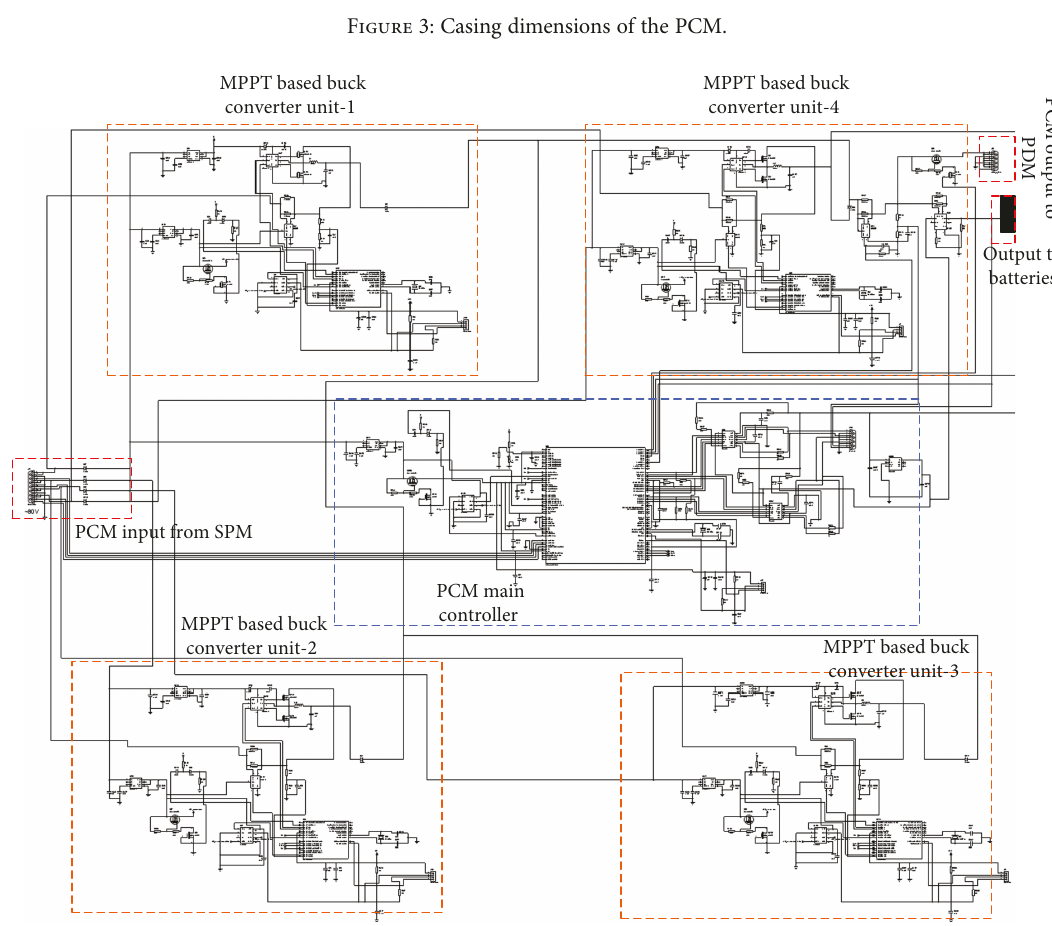
Figure 4: PCM complete